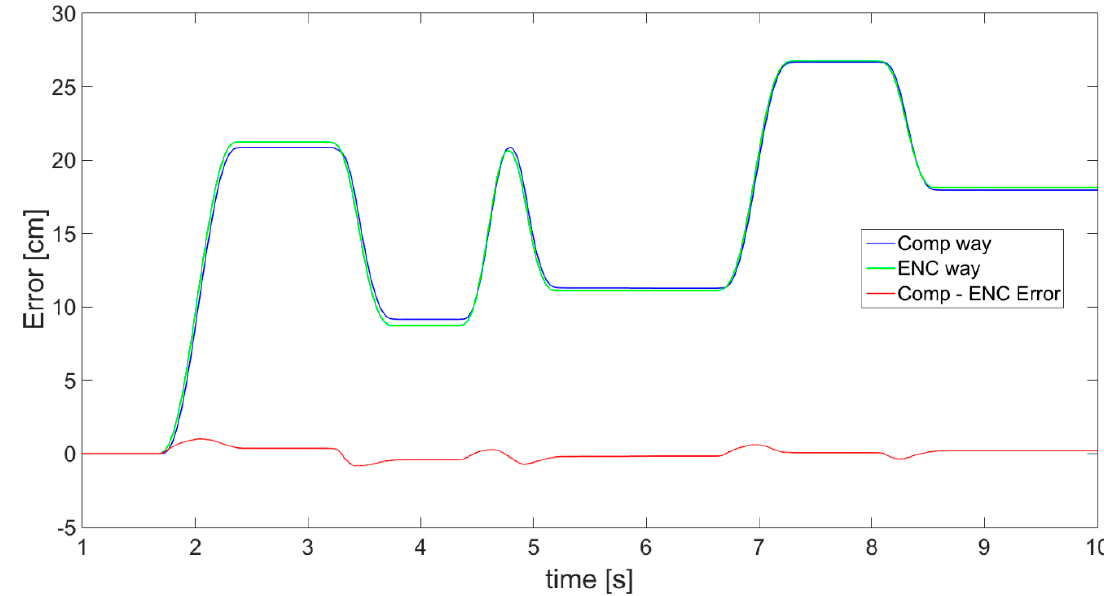
Figure 22. Results of displacement: estimated from sensor fusion between the accelerometer and OFS with usage of a